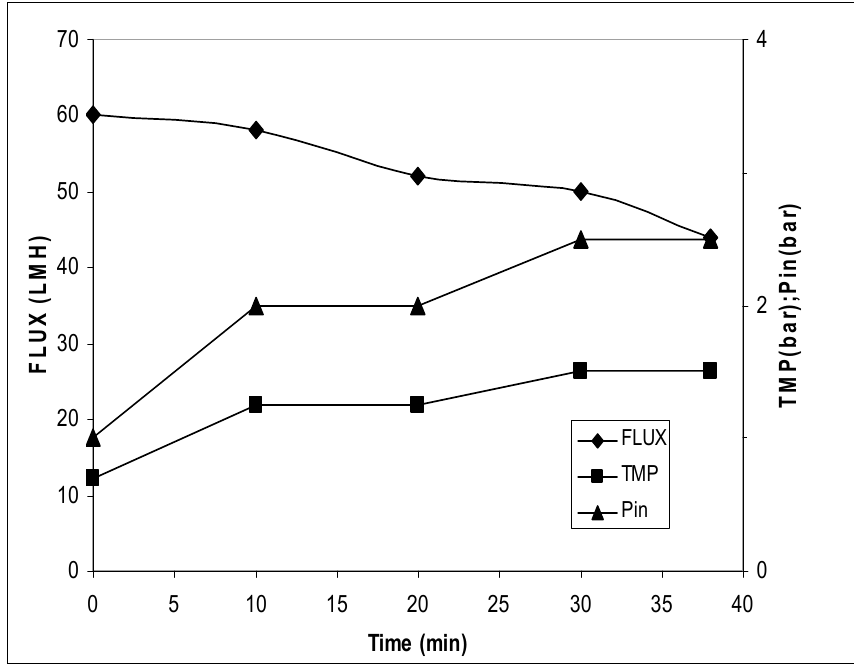
Figure 8. Transmembrane flux, corresponding TMP, and inlet pressure during the ultrafiltration treatment. The experiments were performed in triplicate.